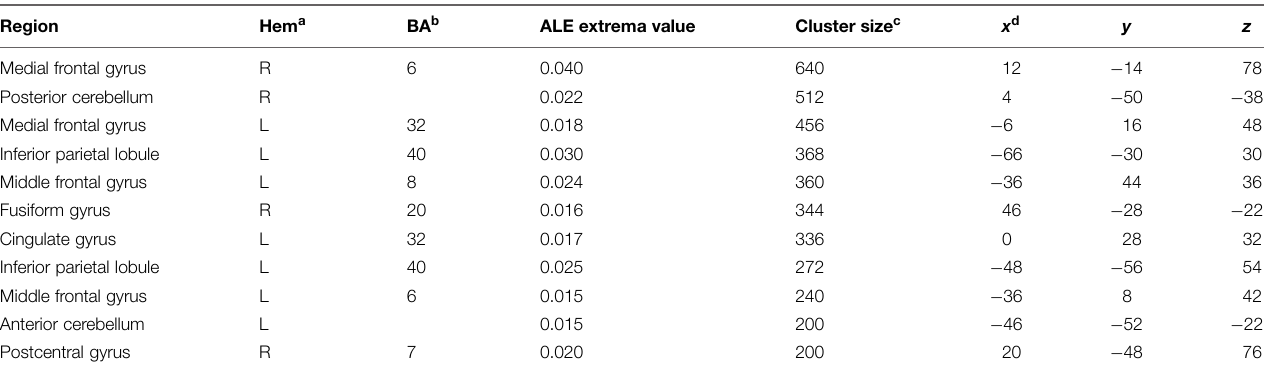
TABLE 3 | Regions showing consistent activations across fMRI studies of musical creativity.